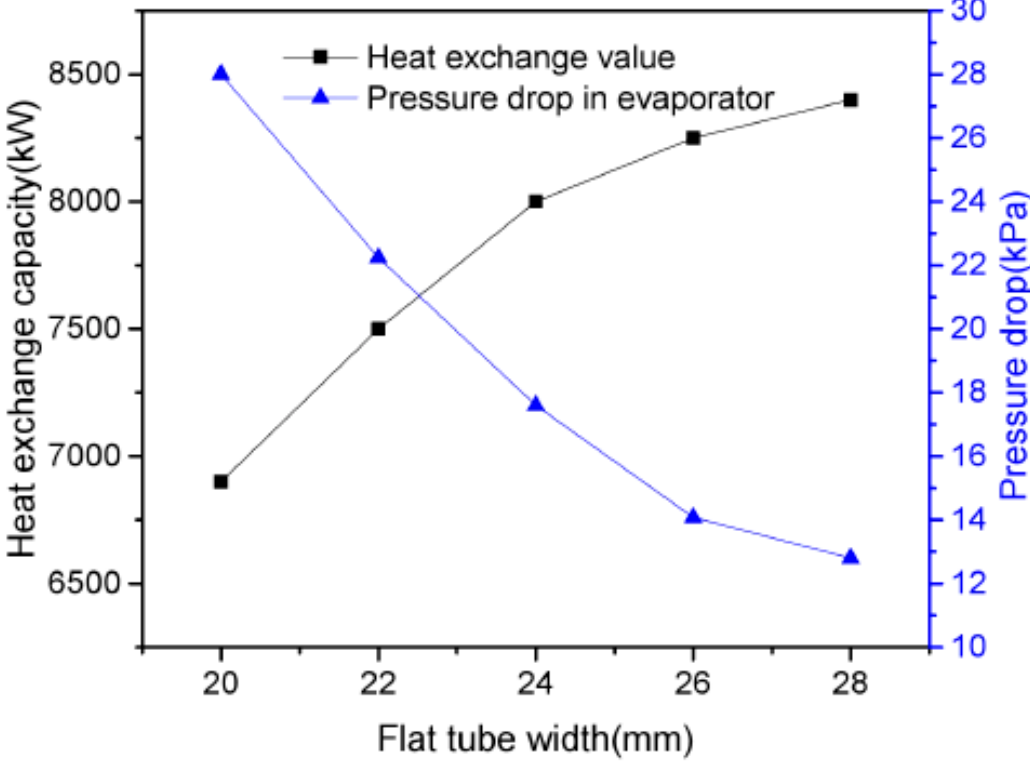
Figure 14. Heat exchange capacity and pressure drop in the evaporator as a function of flat tube